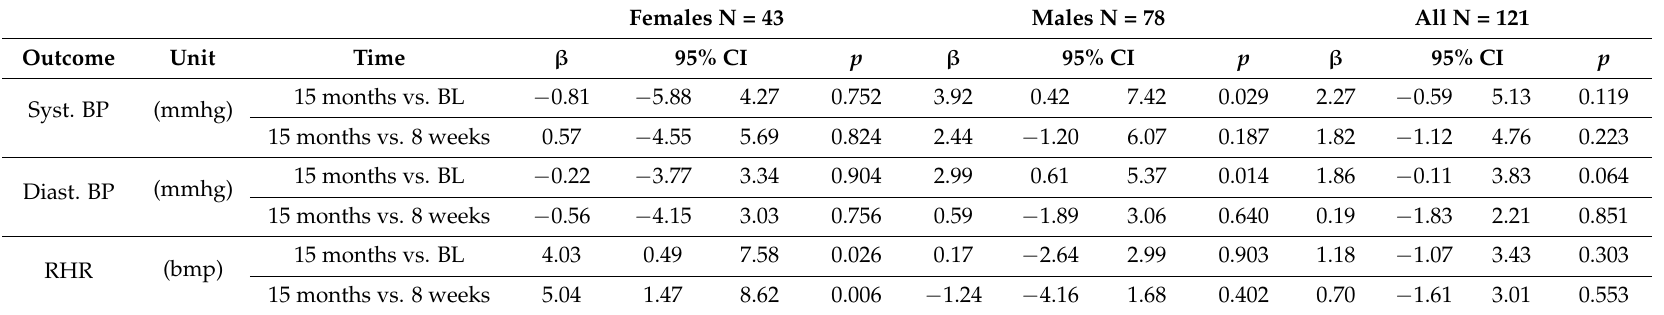
Table 2. Systolic blood pressure, diastolic blood pressure, and resting heart rate.